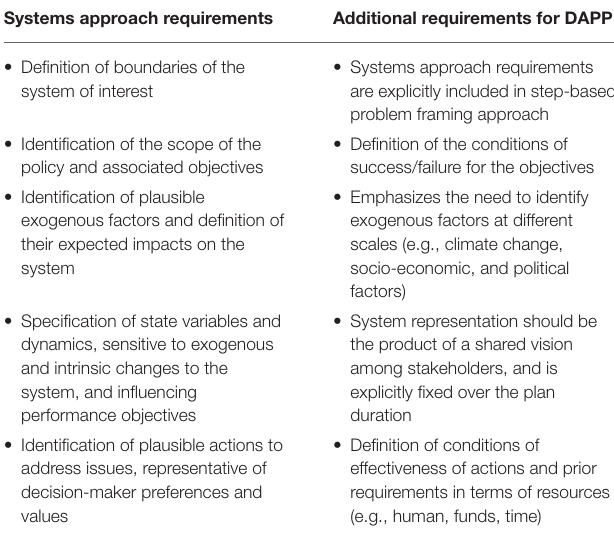
TABLE 1 | Summary of DAPP information requirements in the problem framing step, distinguishing additional requirements from those common to other systems approaches to